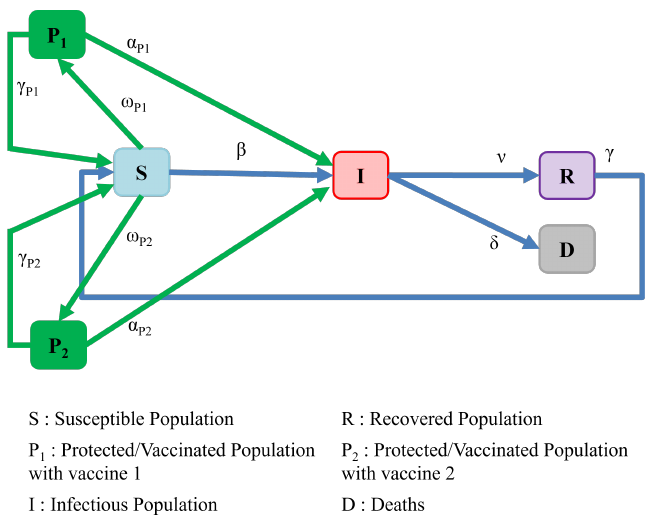
Figure 8. Model of population interactions with different vaccine